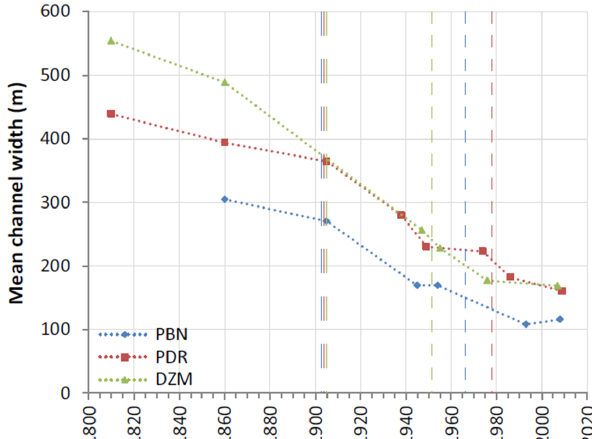
Figure 12. Temporal variation in the mean active channel width of three reaches of the Rhône between 1810 and 2009. Long dashed lines correspond to the Girardon training phase and short dashed lines correspond to the channel bypassing for each reach (Tena et al.,